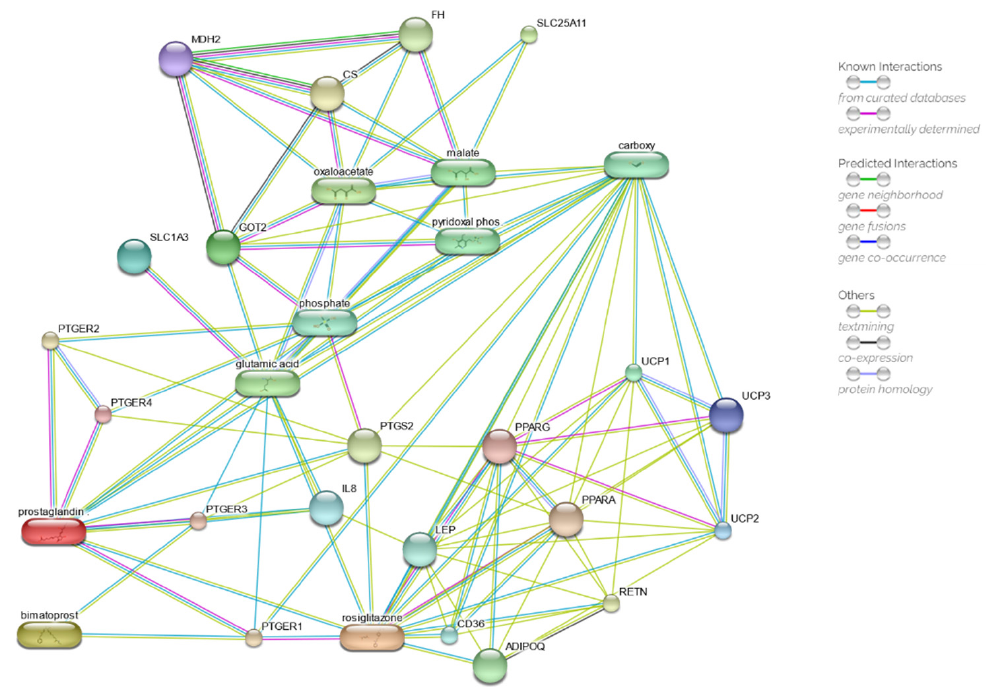
Figure 7. Drug–target network, obtained by STITCH database, of prostaglandin E2 (PGE2), bimatoprost, and rosiglitazone. Chemicals are represented as pills; proteins are represented as spheres. ADIPOQ, adiponectin; CD36, thrombospondin receptor; CS, citrate synthase; FH, fumarate hydratase; GOT2, mitochondrial glutamic-oxaloacetic transaminases 2; IL8, interleukin 8; LEP, leptin; MDH2, mitochondrial malate dehydrogenase 2; PPARA, peroxisome proliferator-activated receptor alpha; PPARG, peroxisome proliferator-activated receptor gamma; PTGERs, prostaglandin E receptors; PTGS2, prostaglandin E receptor 2 (subtype EP2); RETN, resistin; SLC1A3, solute carrier family 1, member 3; SLC25A11, solute carrier family 25, member 11; UCPs, uncoupling proteins. More detailed information and the interactive network can be retrieved at the link: http://stitch.embl.de/cgi/network.pl?taskId=ncdxT1FhAA9i (accessed on 11 November 2022).